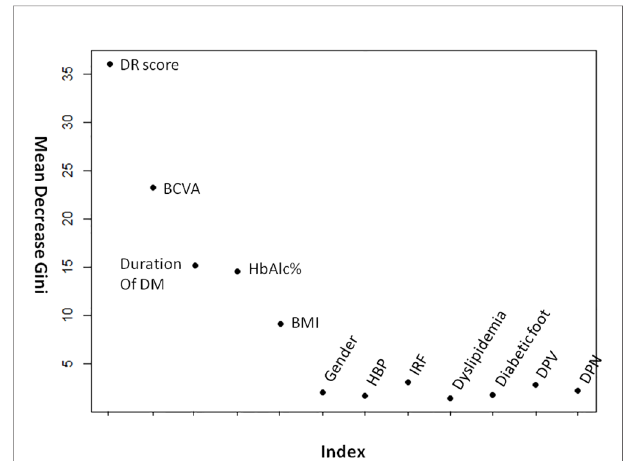
FIGURE 5 | The mean decrease gini values of DR- related factors. BCVA, best-corrected visual acuity; BMI, body mass index; HBP, high blood pressure; IRF, impaired renal function; DPV, diabetic peripheral vasculopathy; DPN, diabetic peripheral